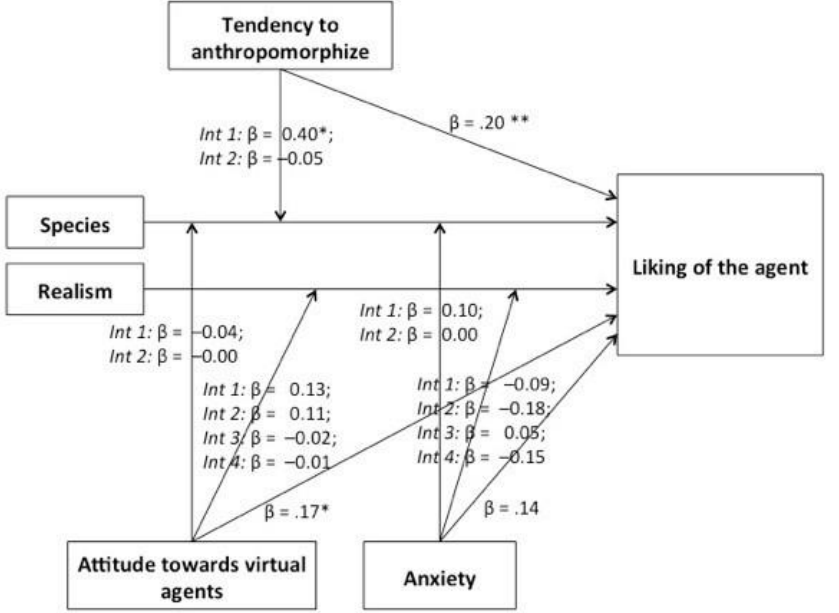
Figure 5. Conceptual m odel of the moderating variables’ effects on liking of the agent. Standardized regression coefficients are presented (* indicates a p value < 0.005 and ** <0.001). For the moderation analyses, independent variables were dummy coded (species: Int 1 = human vs. animal, Int 2 = human vs. robot; realism: Int 1 = high detail vs. low detail, Int 2 = high detail vs. cartoon proportions, Int 3 = high detail vs. cartoon shade, Int 4 = high detail vs. cartoon proportions with cartoon shade) and data were standardized before running the analyses.